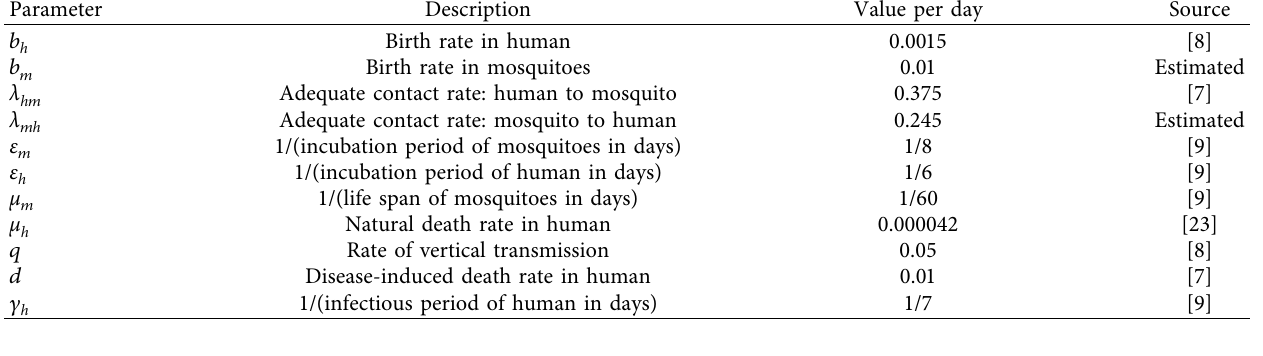
Table 2: Parameters and their description.